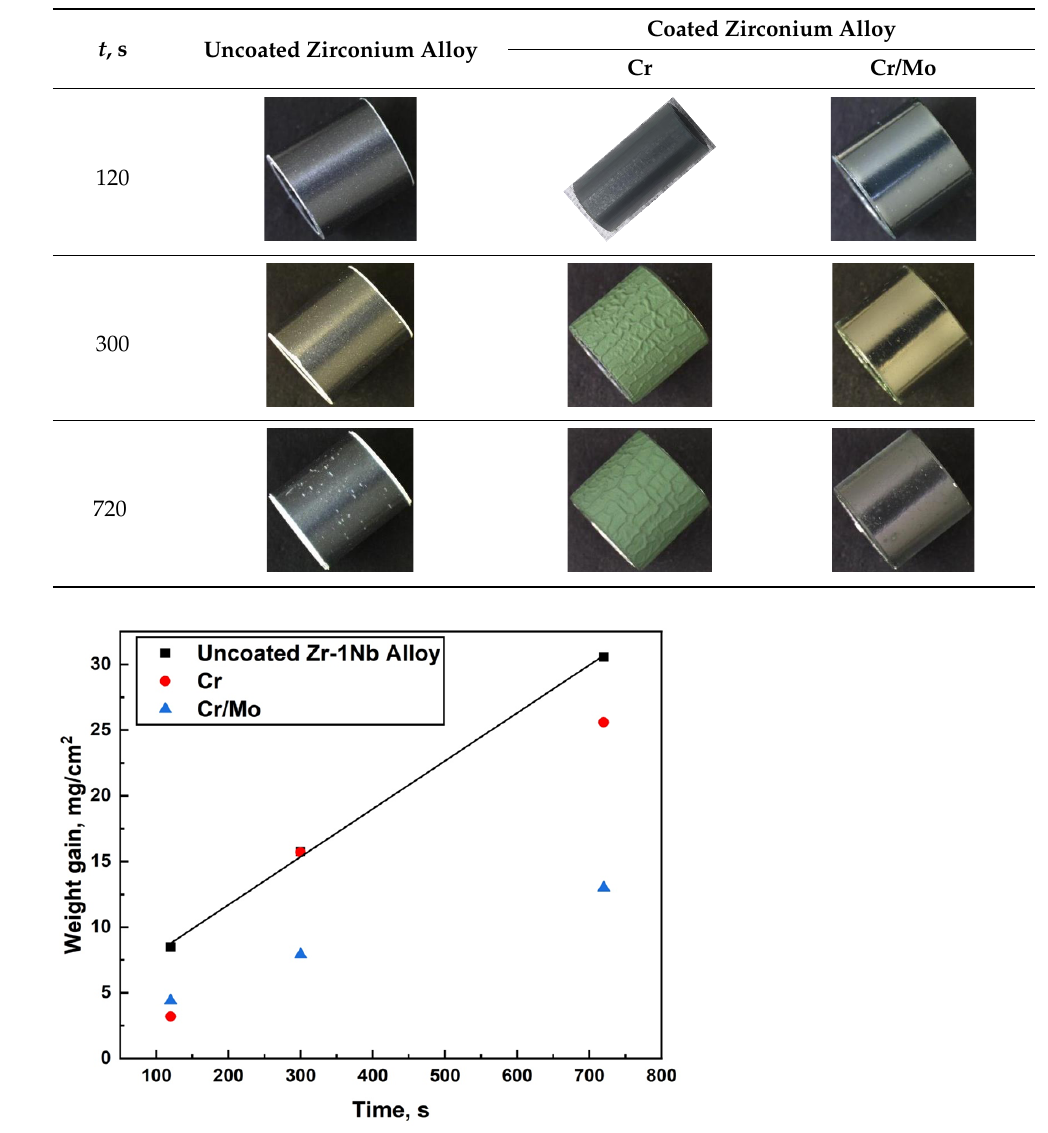
Table 3. The outer view of the samples after oxidation at 1330 °C.